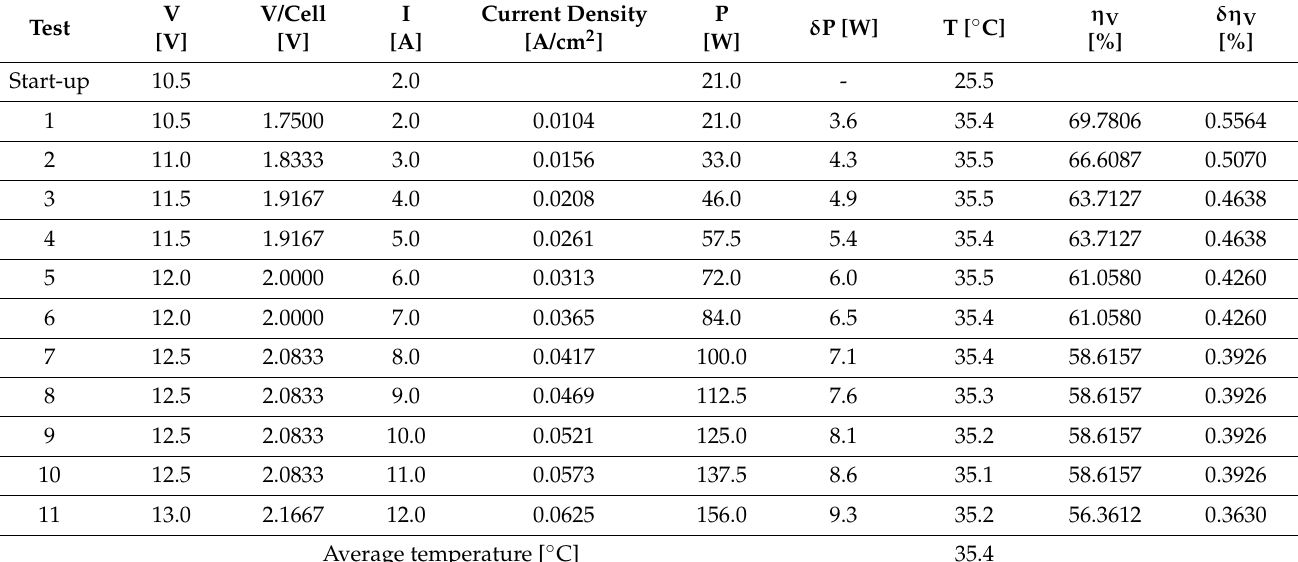
Table 9. Results obtained for the calculation of the theoretical efficiency ( η U ) of the dry cell for 20% ( w/w ) KOH. The letter “ δ ” means the experimental error of a given